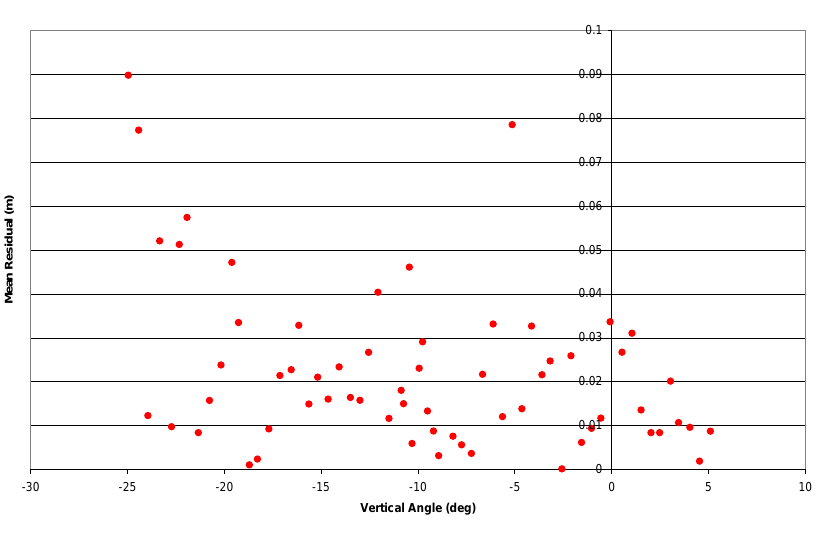
Figure 8. Magnitude of Mean Range Residual vs Laser Vertical Angle. Magnitude of Mean Range Residual Vs Laser Vertical